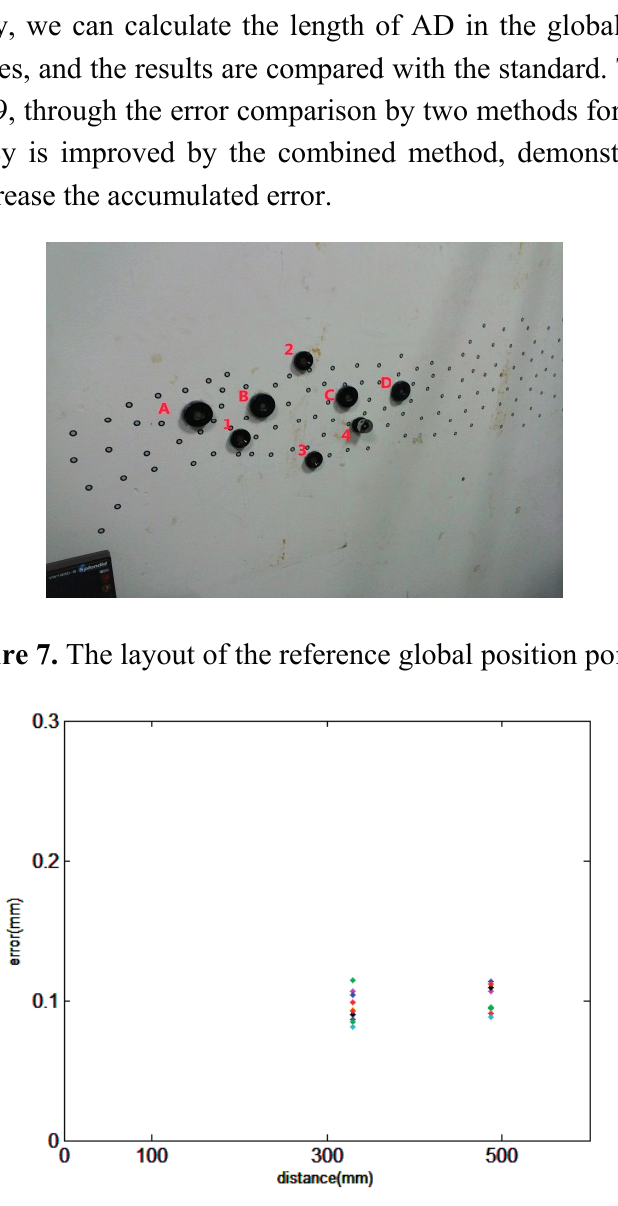
Figure 8. Measurement error of the lengths of AC and AD using the combined method.